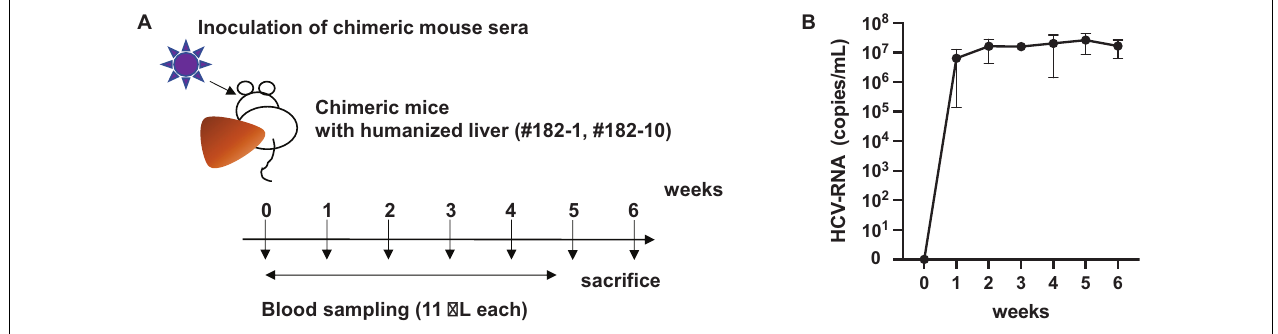
FIGURE 2 | Infection of chimeric mouse. (A) Which was amplified once in chimeric mouse with a humanized liver. The chimeric mouse was bled every week and sacrificed after 6 weeks of infection. (B) HCV RNA amount in two chimeric mouse serum samples (PXB182-1, PXB182-10) was quantitated by qRT-PCR, and their average values were indicated. Vertical bars indicate the standard deviation (SD).